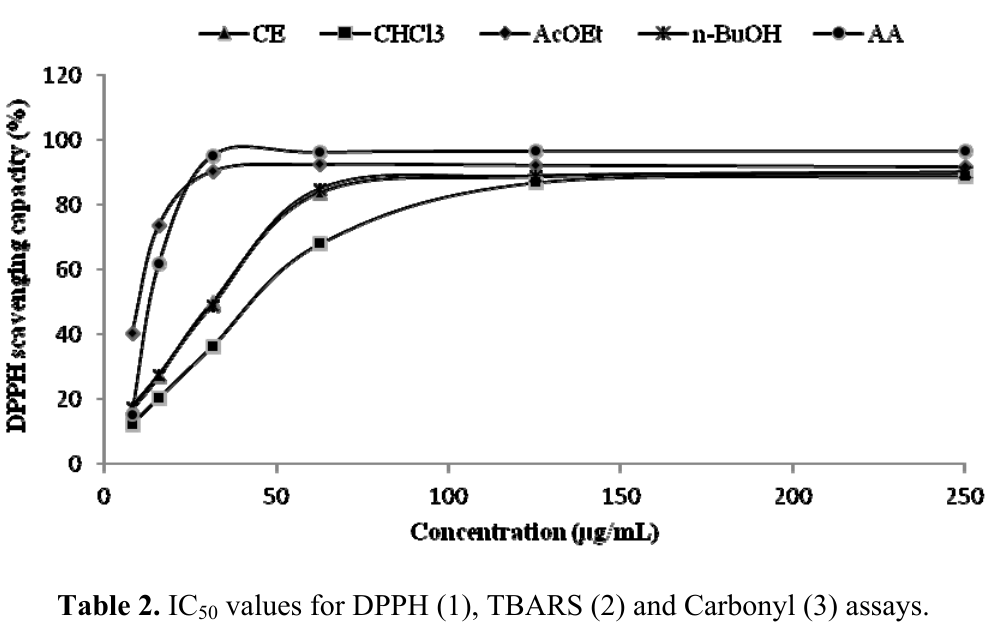
Figure 1. Antioxidant capacity of CE and fractions from leaves of S. guaraniticum by DPPH assay (n = 3).